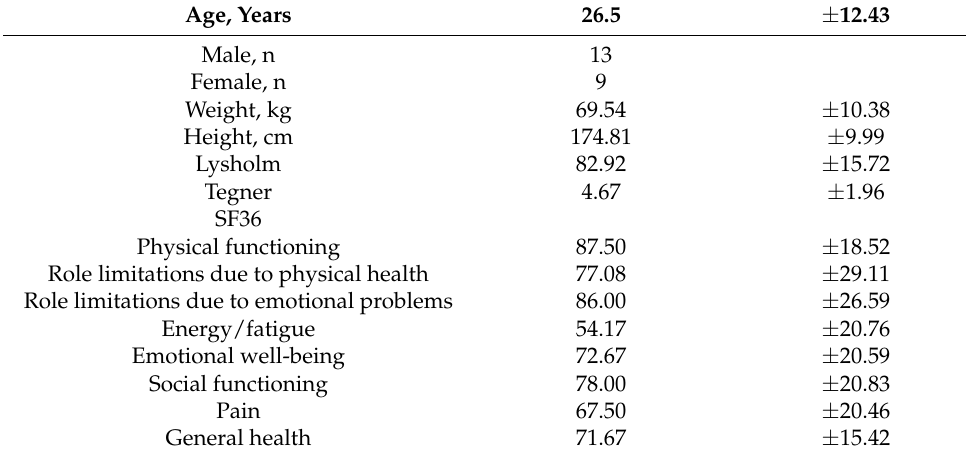
Table 1. Descriptive values of